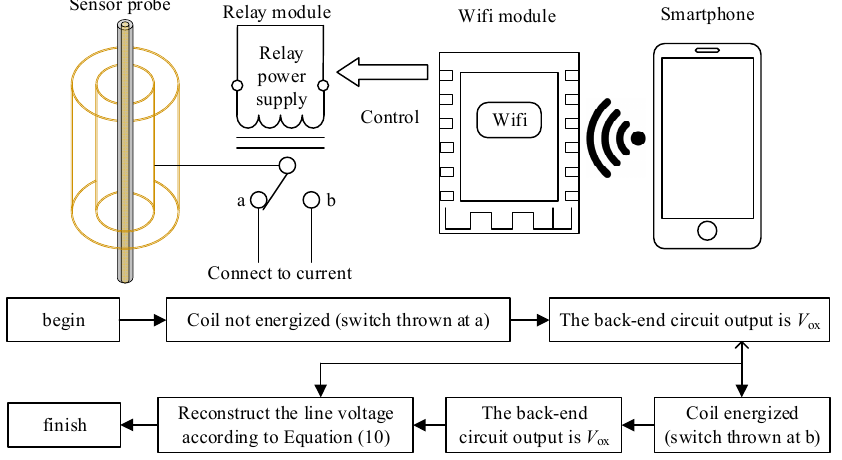
Figure 5. Calibration control elements and